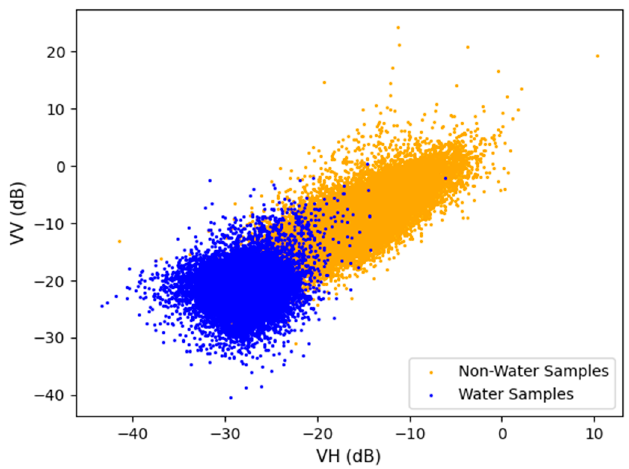
Figure 5. The distribution of training samples in VH–VV two-dimensional space.